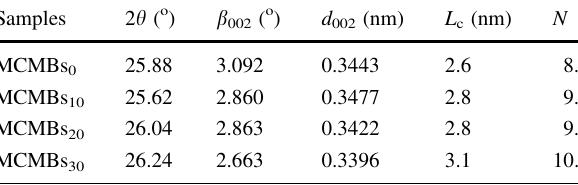
Table 7 The microstructure parameters of MCMBs